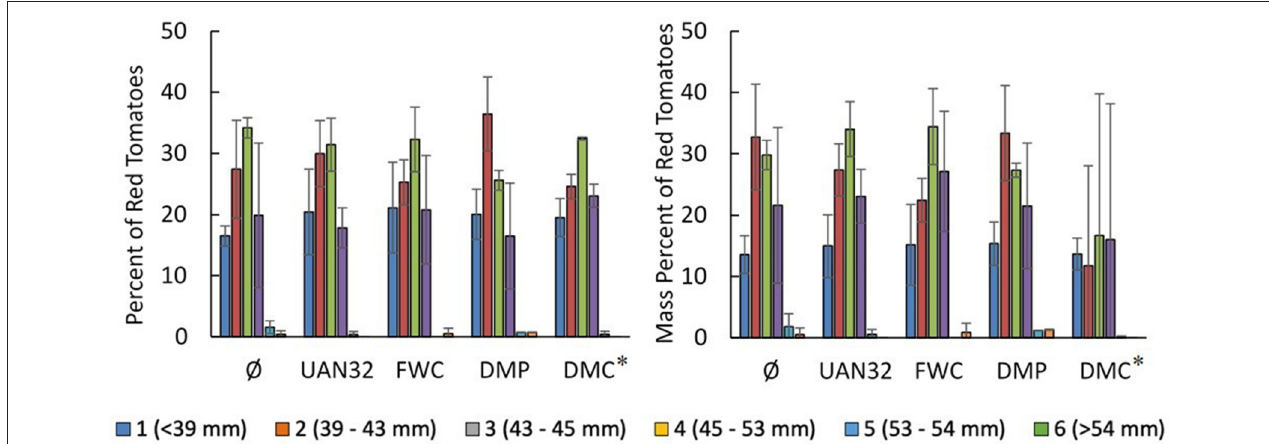
FIGURE 4 | Size distribution of red tomatoes obtained as percentage of the total number of tomato fruits collected (Left) and the percentage of the total mass of tomato fruits (Right) ( n = 3). *Note that the DMC treatment was abandoned after the first fertigation event due to difficulties in applying it due to excessive particle flocculation.